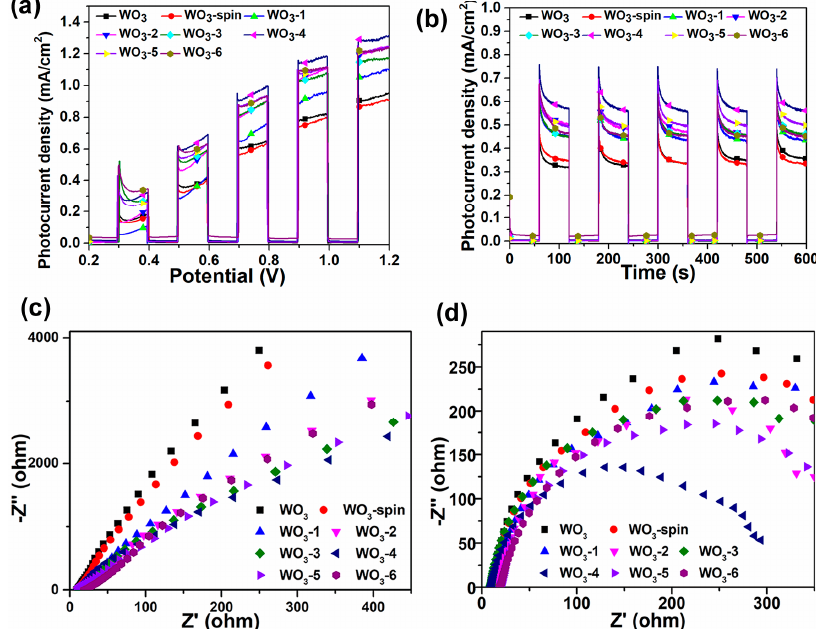
Figure 3. ( a ) linear sweep voltammetry (LSV) and ( b ) current–time (I–t) curve of N-PDI-P/WO 3 composite materials; electrochemical impedance spectroscopy (EIS) of WO 3 films and N-PDI-P/WO 3 composite materials under ( c ) dark and ( d ) light conditions. WO 3 represents a pure WO 3 sample; WO 3 -1, WO 3 -2, WO 3 -3, WO 3 -4, WO 3 -5, and WO 3 -6 represent N-PDI-P/WO 3 composite materials,